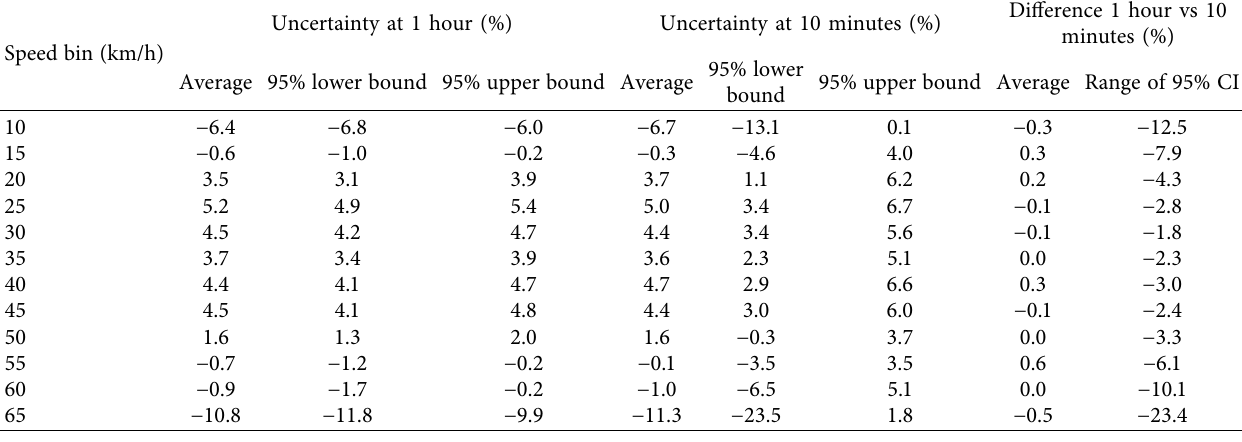
Table 2: The average, lower, and upper bound of 95% CI and CV of estimation